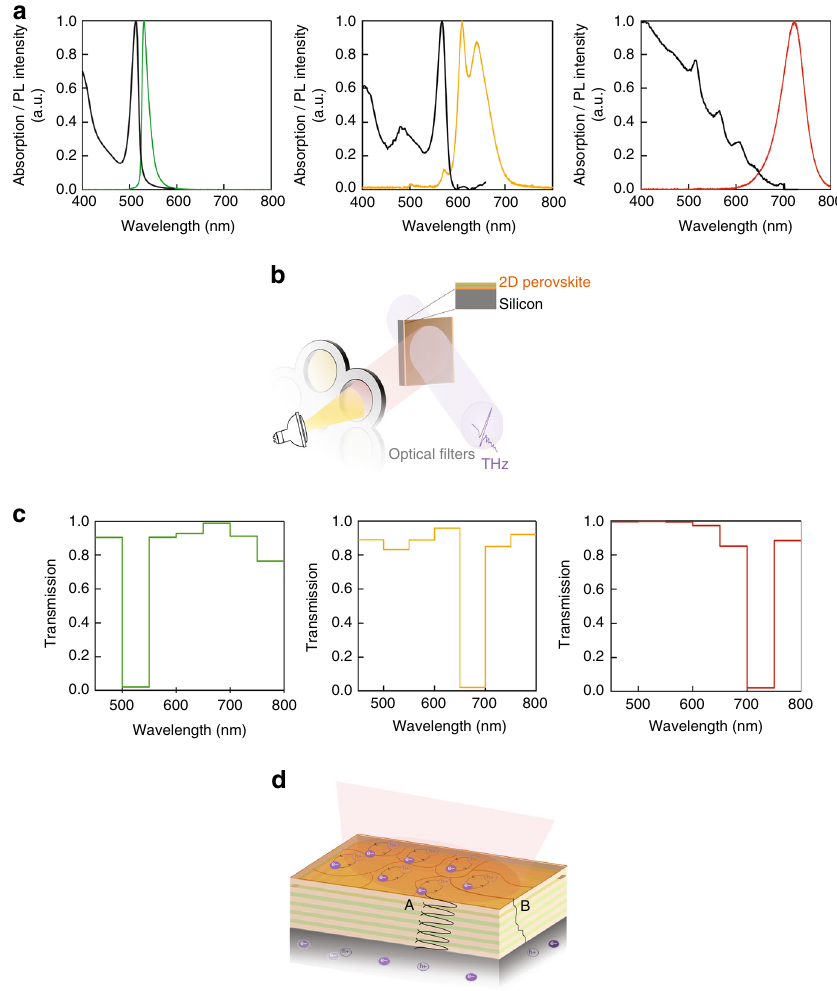
Fig. 2 Excitation spectra of the THz extinction based on various 2D perovskites. a Photoluminescence spectra of the 2D perovskites used in this work and the associated UV – vis absorption (black curves). b Schematic depicting the measurement concept. The 2D perovskite samples were photoexcited using a fi ltered halogen lamp. c Transmission spectra of the silicon/perovskite samples for n = 1 layer (green), n = 2 layer (yellow), and n = 3 layer (red) 2D perovskites. The strong absorption of THz radiation occurs in the same narrow-band optical range as the photoluminescence spectra in a . d An expanded view of the device showing multiple 2D perovskites layers forming a superlattice. The schematic shows two possible mechanisms for exciton dissociation into free carriers. Mechanism A: excitons that are normally con fi ned to the lead-halide plane, exhibit overlapping wavefunctions in the superlattice and tunnel into the silicon substrate, where they can dissociate thereby contributing to the THz absorption. Mechanism B: excitons diffuse through edge states (grain boundaries) where they dissociate into free carriers 38 . These free carriers could diffuse to the underlying silicon through the voids in the polycrystalline fi Fig. 1c, we quantify the THz transmission at 1 THz for perovskite thin layers deposited on different substrates with an optical excitation intensity of 0.5 W/cm 2 . What is clear from the data is the value of placing a perovskite fi lm directly onto a silicon layer (with only a 1 nm native oxide fi lm between the two media). It should be noted that the transmission for n = 1 and n = 3 2D perovskite/silicon samples exhibited nearly the same behavior as the n = 2 2D perovskite/silicon sample (Supplementary Note 1). However, when the perovskite layer is placed on a thicker dielectric layer (200 nm), there is no appreciable increase in THz absorption, demonstrating that carrier generation in the per- ovskite layer itself does not contribute to the THz absorption (Supplementary Note 2). It is the interface between the silicon and perovskite that dramatically enhances broadband THz absorption upon optical illumination. It is worth noting that graphene/semiconductor bilayer structures have been shown to exhibit enhanced photo-induced absorption, mediated by charge